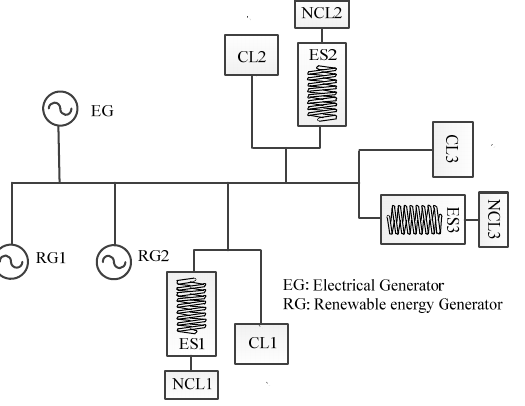
Figure 1. Microgrid with renewable-energy generators, electrical generators, and electric springs.